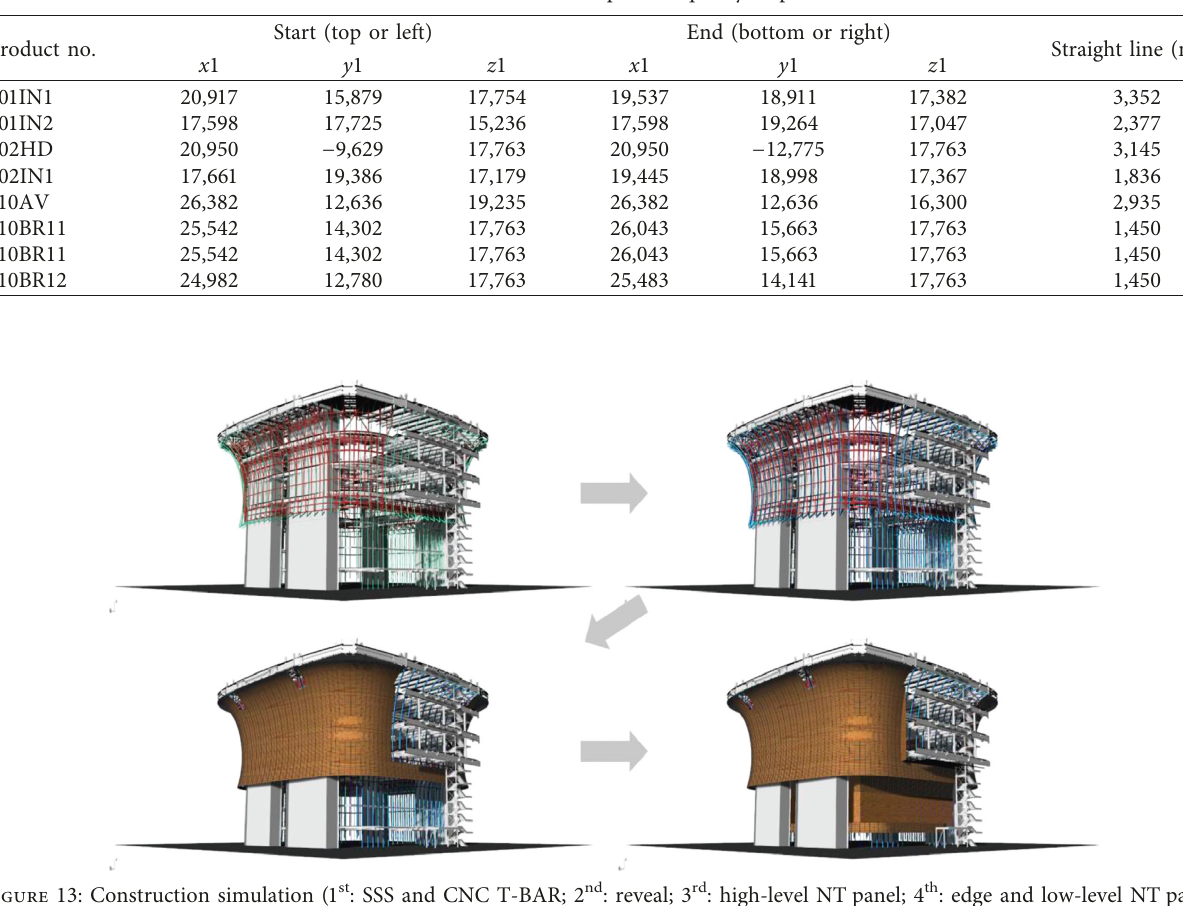
Table 3: Member list and information samples for quality inspection of CNC T-BAR.